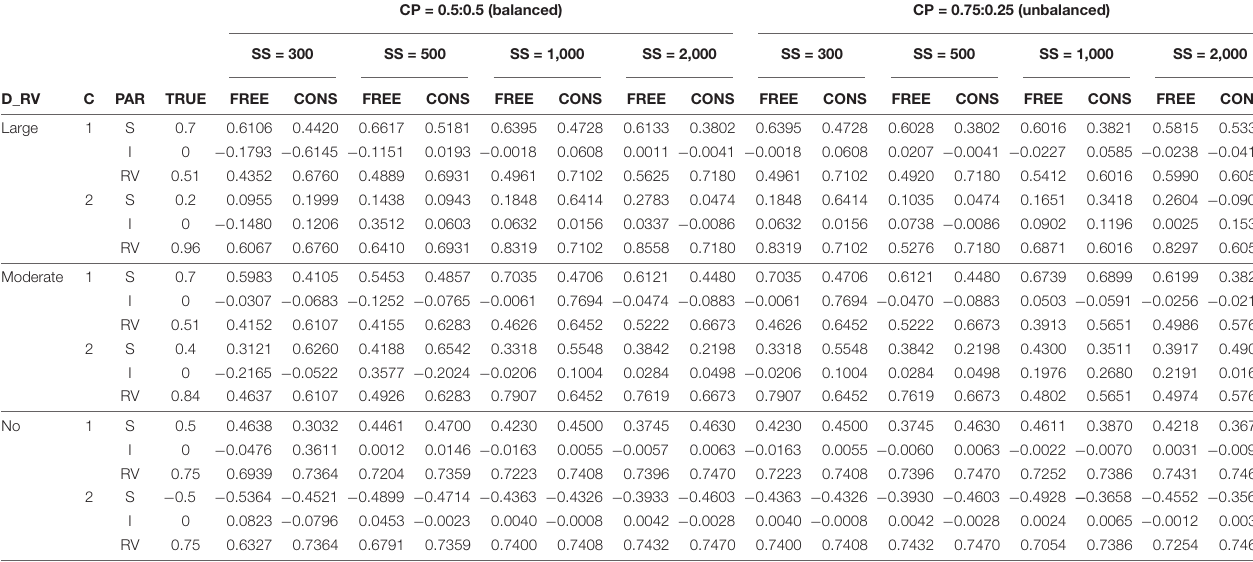
FREE, residual variances freely estimated; CONS, residual variances equally constrained; SS, sample size; CP, class proportion; D_RV, the disparity in the magnitude of class-specific residual variances; C, latent class; TRUE, population values for each parameter; PAR, parameters; S, class-specific slope; I, class-specific intercept; RV, class-specific residual variance.